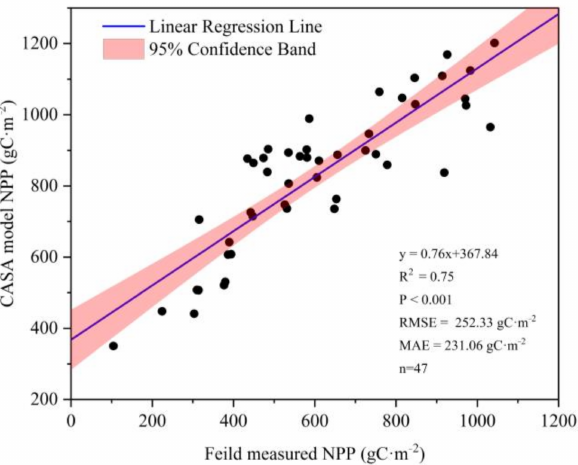
Figure 2. Comparison between the simulated NPP from the CASA model and the field-observed NPP in the